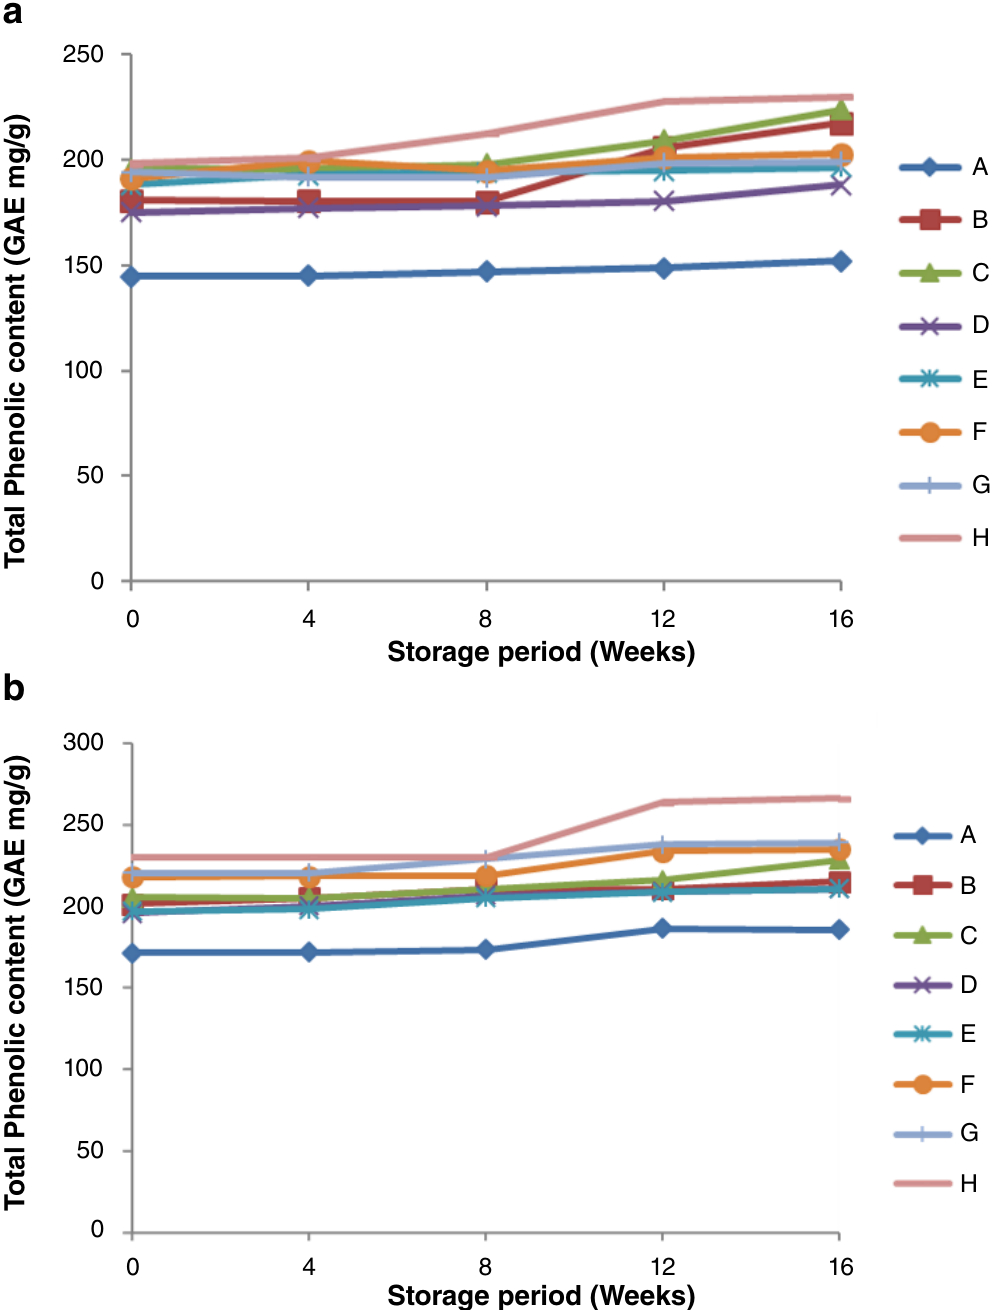
Figure 3. Total Phenolic Content Ogi flour made with ( a ) maize and ( b ) sorghum with Garlic and Ginger. Sample codes: A: Ogi Flour, B: Ogi Flour + 2% Garlic, C: Ogi Flour + 4% Garlic, D: Ogi Flour + 2% Ginger, E: Ogi Flour + 4% Ginger, F: Ogi Flour +2% Garlic + 2% Ginger, G; Ogi Flour+2% Garlic + 4% Ginger, H: Ogi Flour +4% Garlic + 2% Ginger.